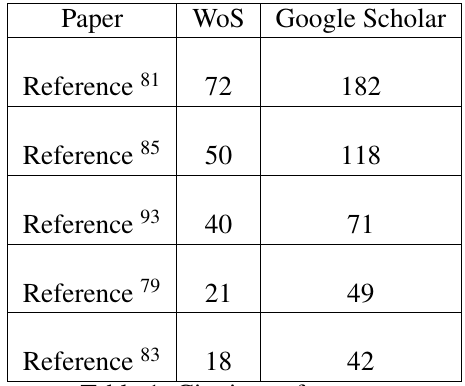
Table 1. Citations of